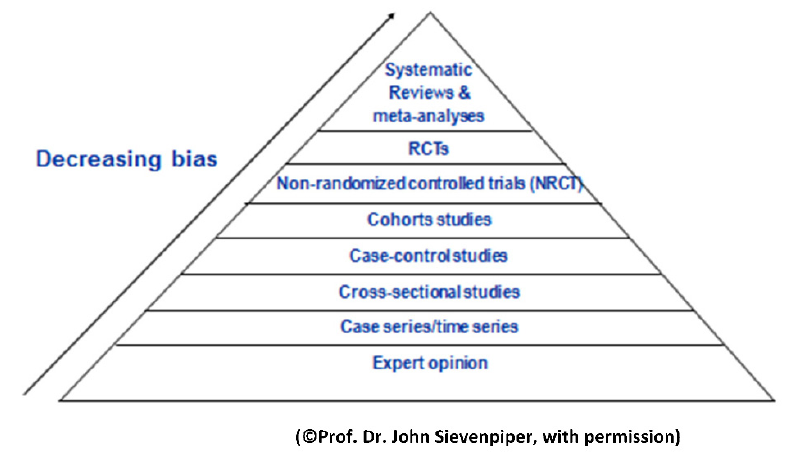
Figure 1. Hierarchy of evidence in evidence based medicine.